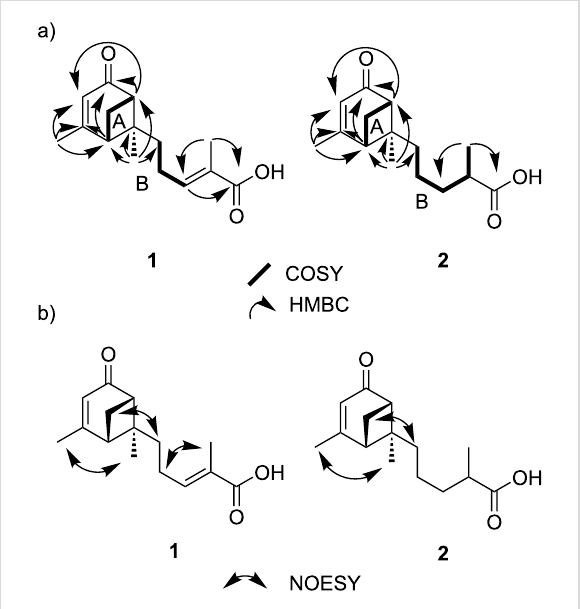
Figure 2: a) Significant 1 H, 1 H-COSY and 1 H, 13 C-HMBC correlations for compounds 1 and 2 . b) Key NOESY correlations for compounds 1 and 2